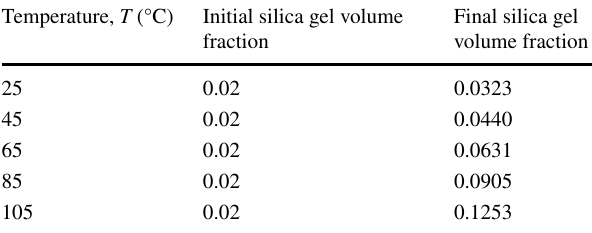
Table 9 Effect of temperature on silica gel volume fraction